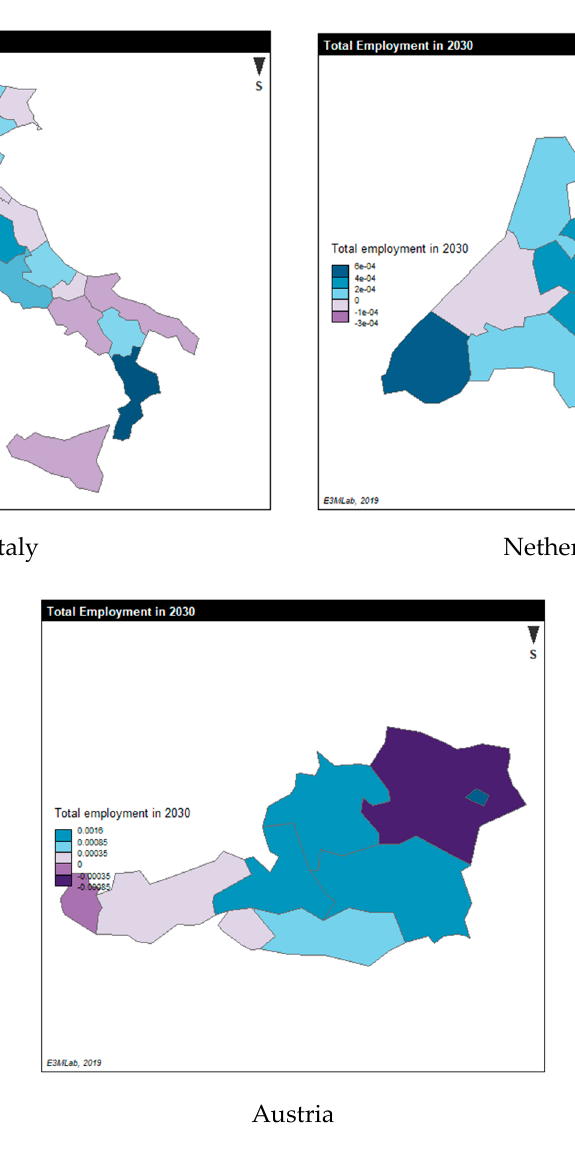
Figure 4. Percentage change in regional employment to the base case in 2030.